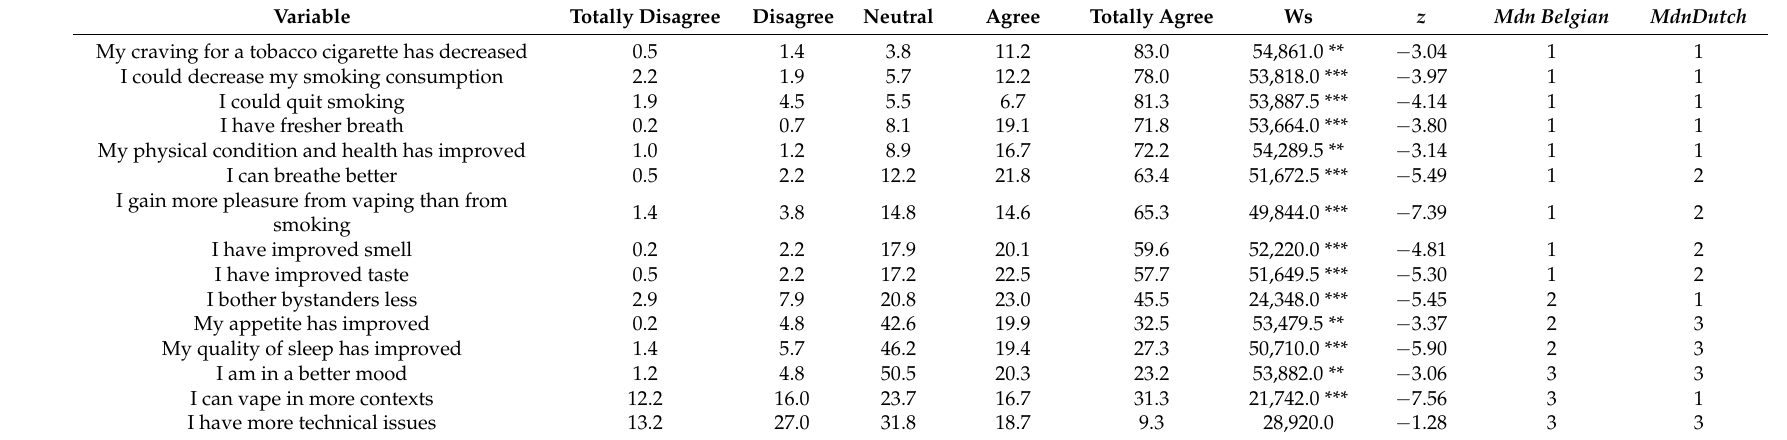
Table 5. Distributions of responses (in %) by current vapers ( n = 418) on a list of several possible improvements due to using e-cigs and differences between customers of the Dutch online vape shop and Belgian vapers contacted via Facebook with regard to these possible improvements. Variable Totally Disagree My craving for a tobacco cigarette has